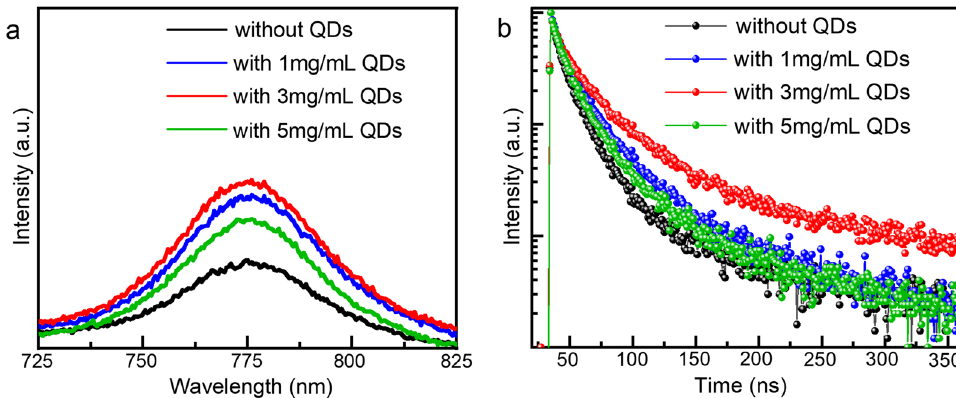
Fig. 4 a PL spectra and b TRPL decay curves of different perovskite films Table 1 TRPL parameters of different perovskite films Film